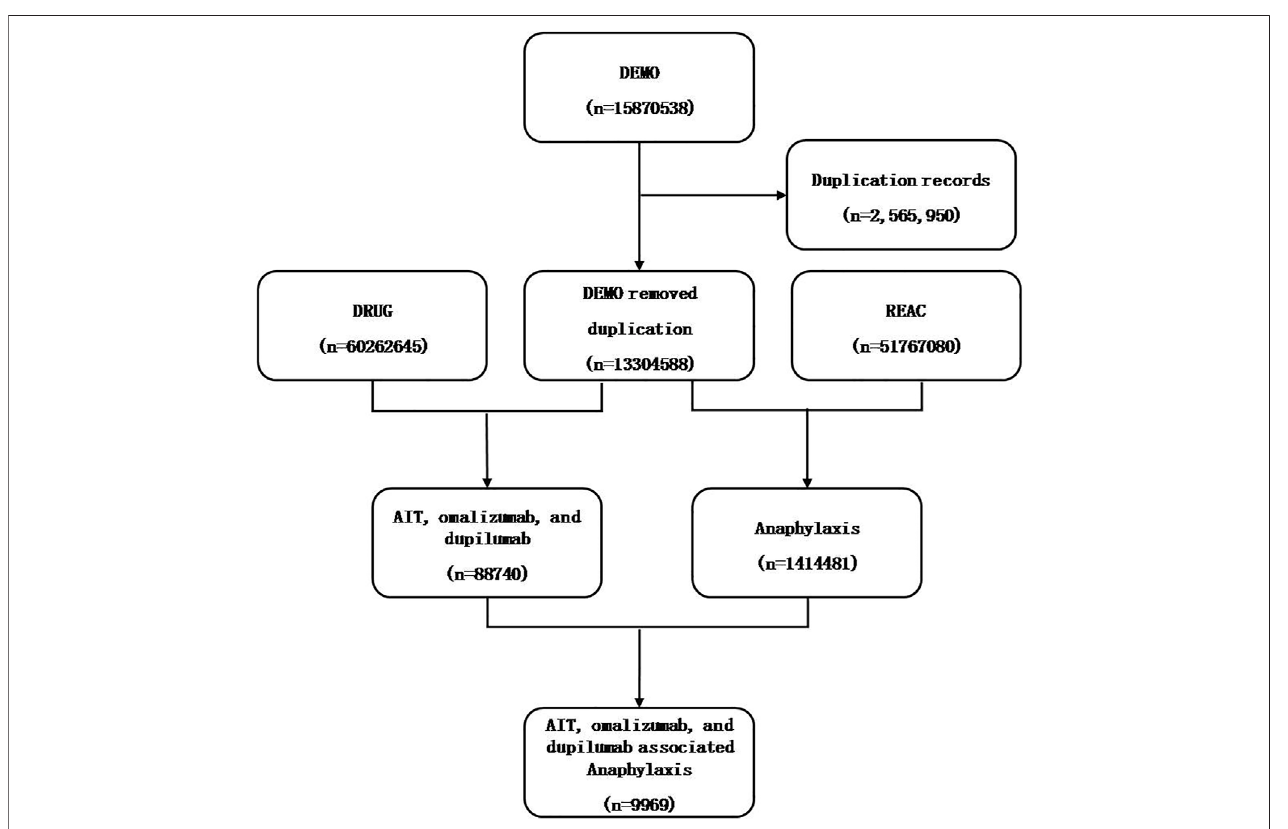
FIGURE 1 | Flowchart of data mining process of anaphylaxis related to AIT, omalizumab, and dupilumab.